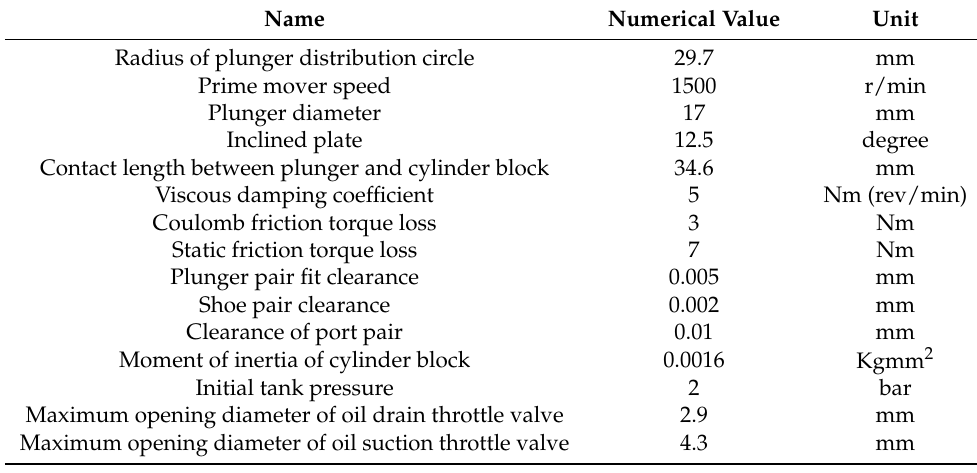
Table 2. Main simulation parameters.